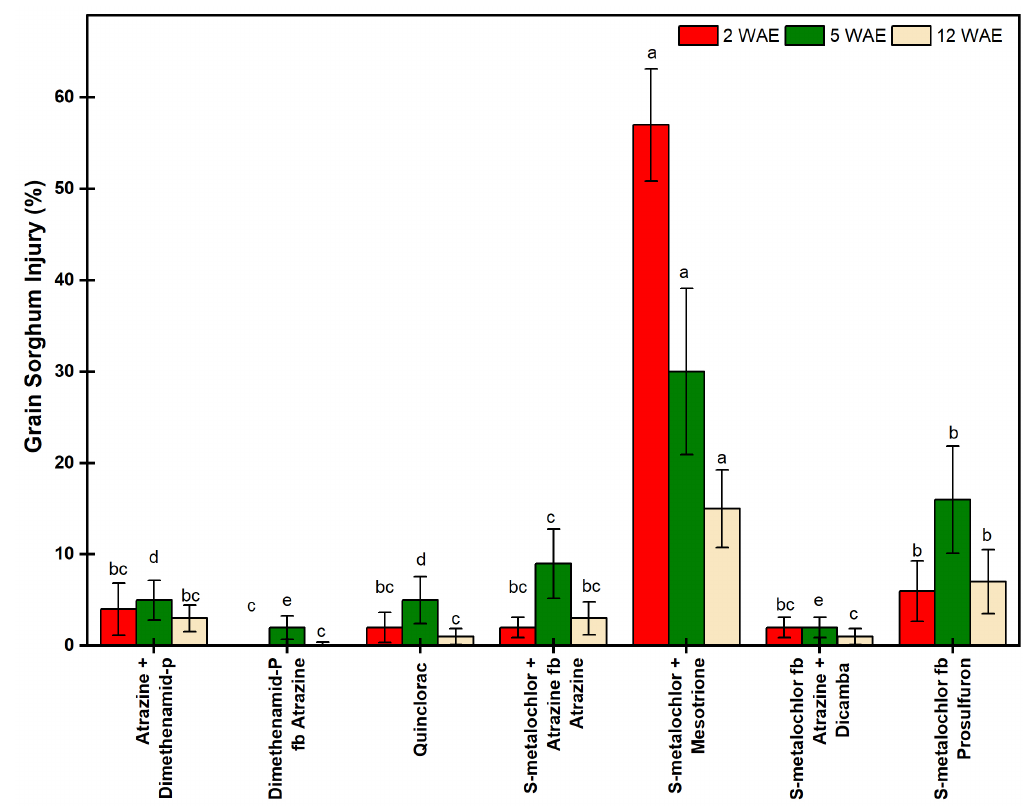
Figure 6. Injury to grain sorghum plants due to di ff erent herbicide treatments at 2, 5, and 12 weeks after emergence (WAE). Data were analyzed separately for each WAE. Data were pooled over three years. The same letters on bars indicate no significant di ff erences at p < 0.05, according to Fisher’s least significant di ff erence